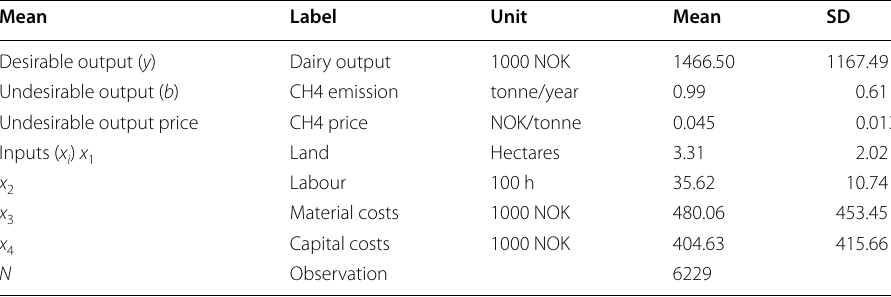
Table 1 Model variables’ descriptive statics used in the translog functions